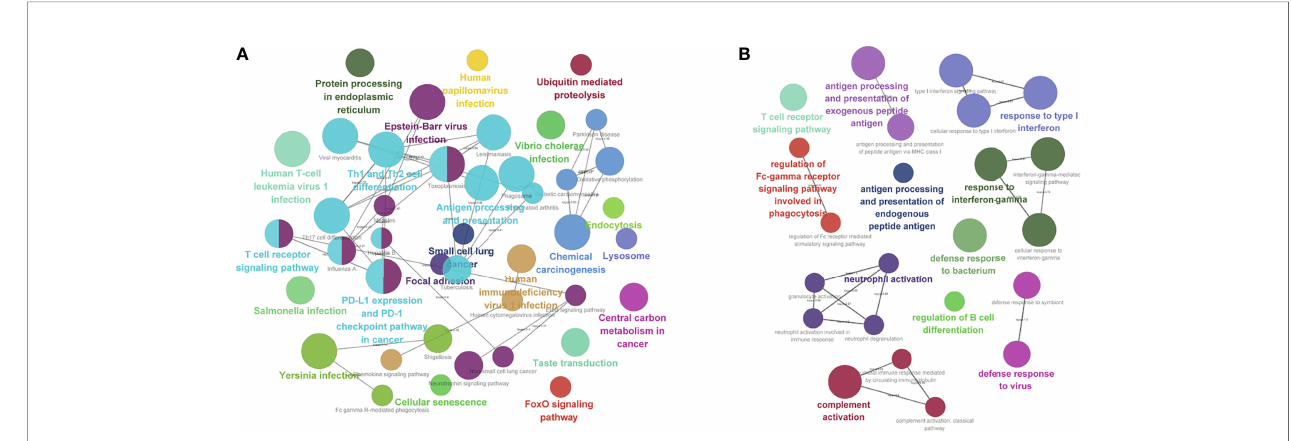
FIGURE 6 | Functional enrichment analysis. (A) KEGG pathway analysis. (B) Enrichment in immune response-related